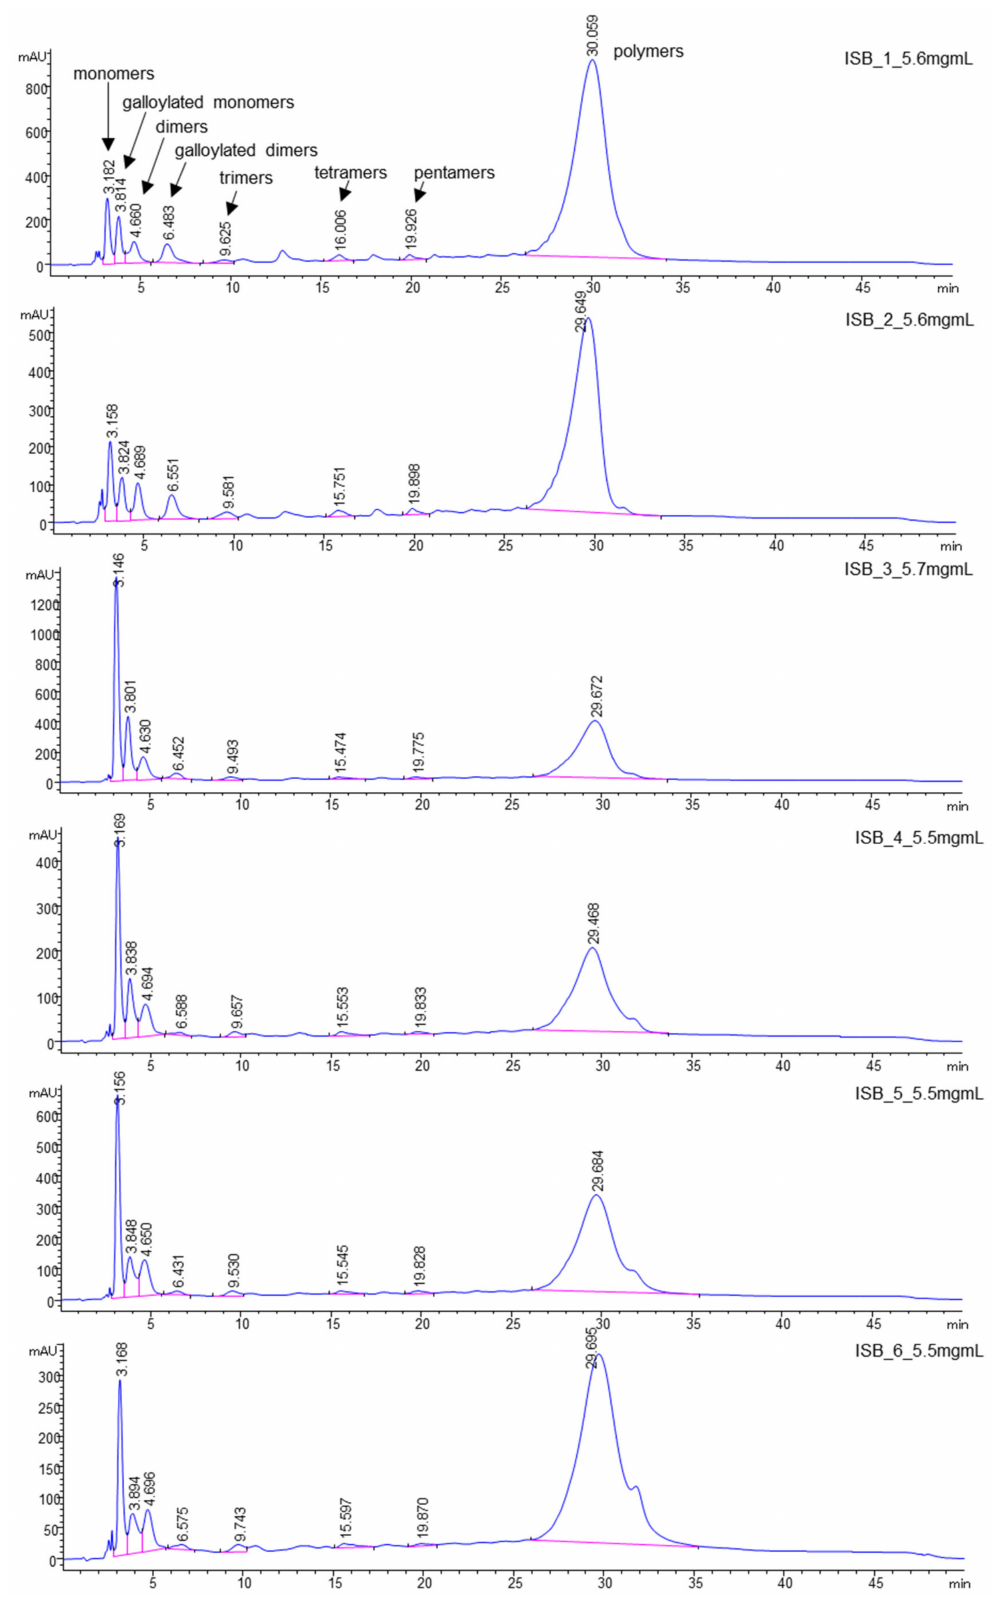
Figure 2. HPLC-chromatograms of proanthocyanidins during berry development and ripening (from top to bottom: six stages 161–293 DAFBs) of black ‘Isabel’ seeds on a Diol column recorded at 280